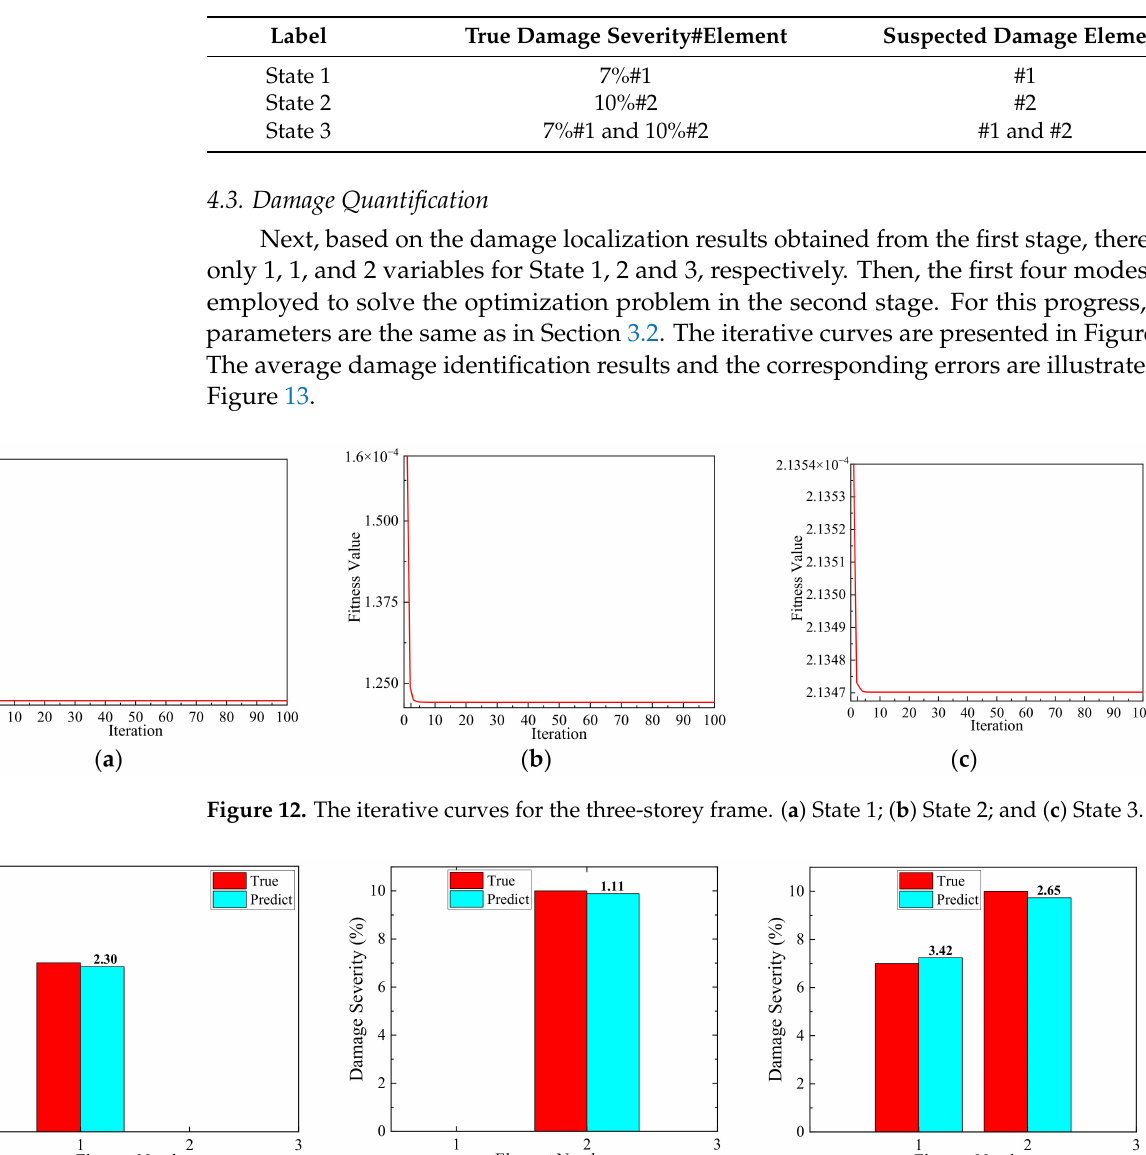
Table 8. Damage localization results of three-storey frame.